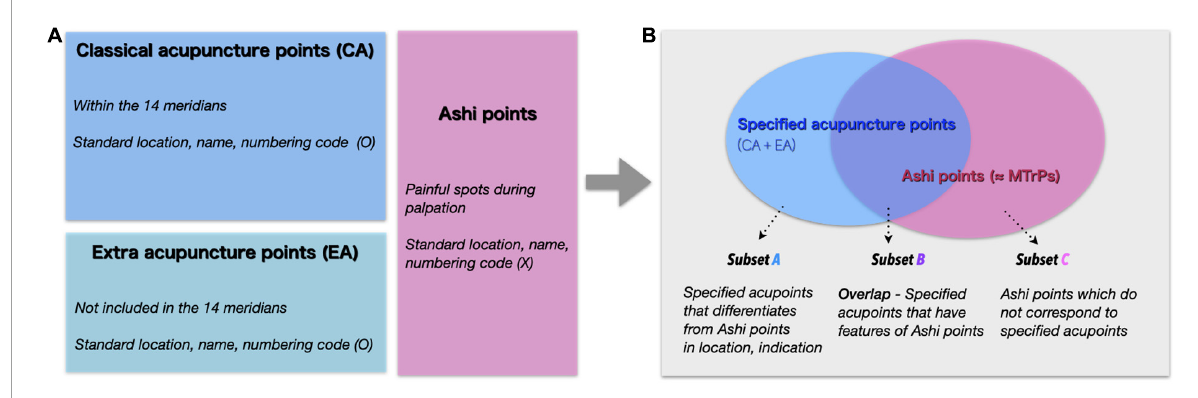
FIGURE1 (A) The classical model of the relationship between acupuncture point subgroups. Classical acupuncture points (CA) in blue, extra acupuncture points (EA) in light blue, and Ashi points in pink. The blue and light blue areas are referred to as specified acupuncture points, comprising CA and EA. The three subgroups are considered mutually exclusive. (B) A new model of the relationship between specified acupuncture points and Ashi points. Subset A, shaded only in light blue, refers to the acupoints that are CA and EA, but not Ashi points. Subset B, which is filled in light purple (specified acupuncture points ∩ Ashi points), represents acupoints that can be CA or EA and Ashi points at the same time, for example when TPs are located in specified acupuncture points. Subset C, colored in pink, represents Ashi areas that are not defined as specified acupuncture